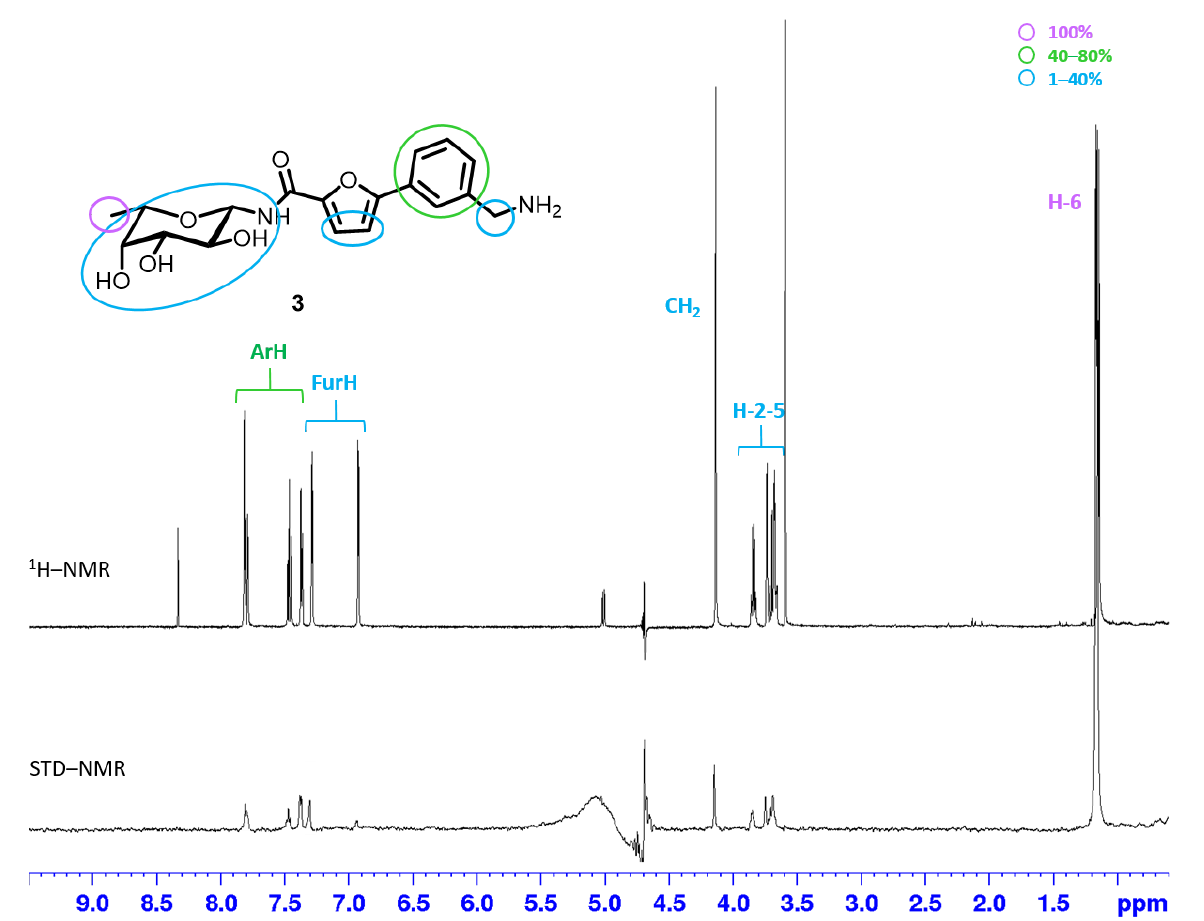
Figure 3. 1 H (top) and STD NMR (bottom) spectra for compound 3 in the presence of BC2L-C-Nt. The STD experiment was acquired on a Bruker Avance 600 MHz at 298 K, irradiating for 0.98 s at − 0.05 ppm in phosphate buffer pH 7.4 with 10% D 2 O. The epitope is represented with a color code: purple circle for protons with 100% relative STD, green for 40–80% and light blue under 40%. For compound 3 , the STD spectrum (Figure 3) revealed that the fucose ring is well inserted in the binding pocket and its C6-methyl group at 1.17 ppm gives rise to the strongest observable contact. The weaker response of the other protons of the sugar ring (3.5–4.0 ppm, rel. STD ca 20%) is consistent with the different nature of the